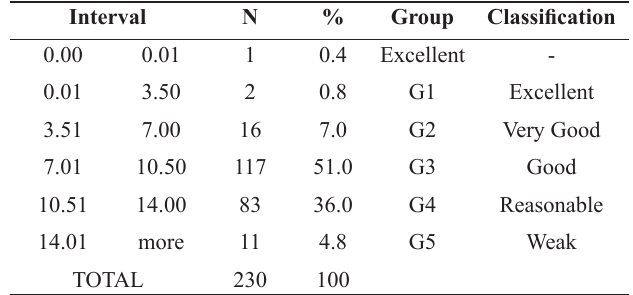
Table 6. Index created for classification of males.